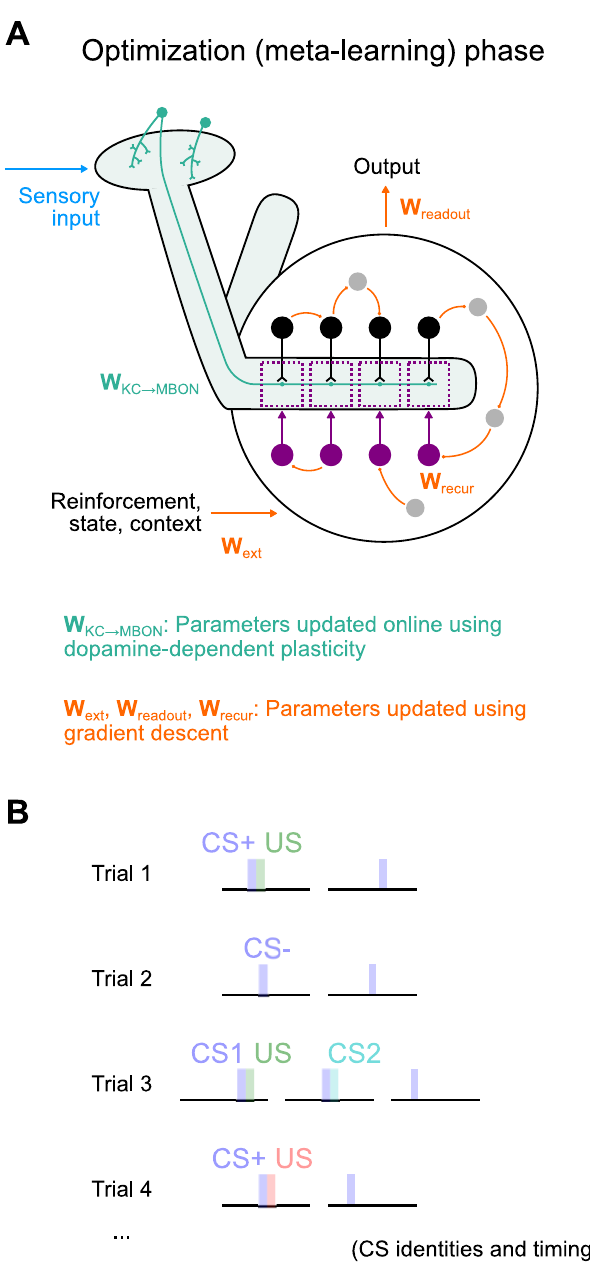
Fig 2. Schematic of meta-learning procedure. (A) Two phases of meta-learning and testing. Left: During the optimization phase, connections that form the mushroom body output circuitry are updated with gradient descent (orange). Kenyon cell to output neuron weights evolve “online” (within each trial) according to dopamine-dependent synaptic plasticity. Right: After optimization is complete, the network is tested on a new set of trials. In this phase, connections that form the output circuitry are fixed. (B) Illustration of trials involving CS/US associations presented during training (left) and testing (right). Each trial involves new CS/US identities and